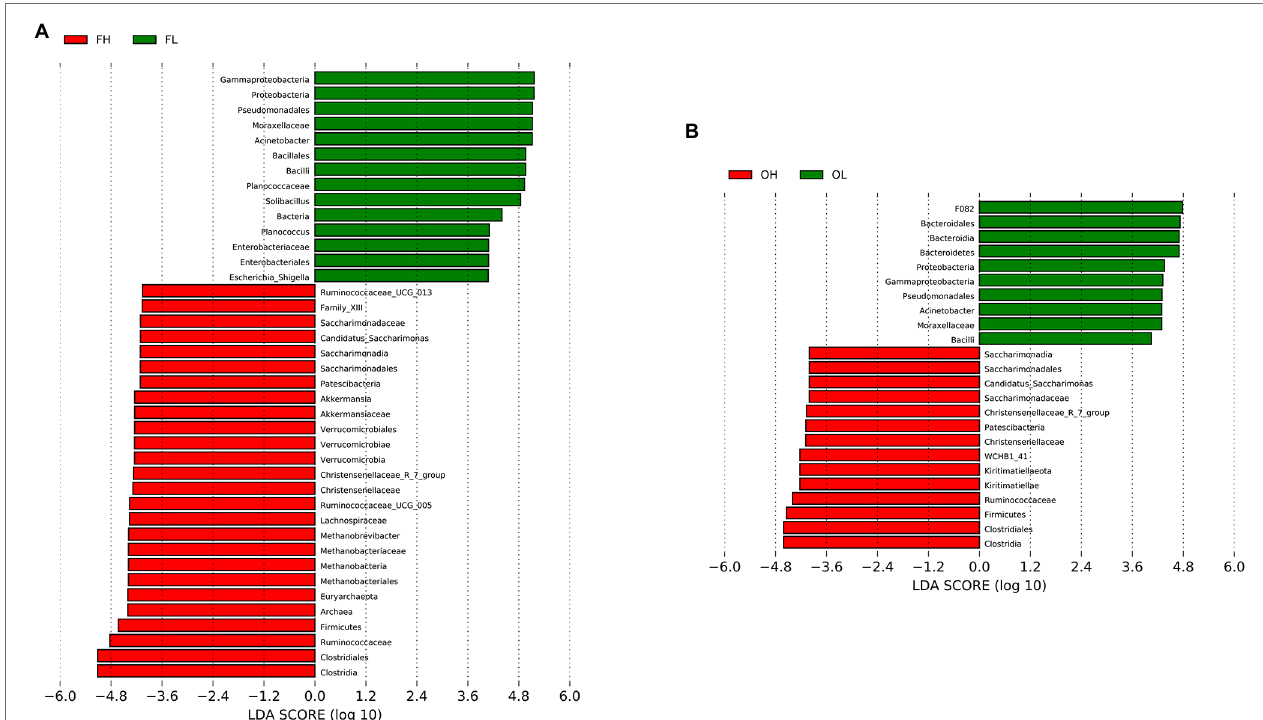
FIGURE 7 | LEfSe (LDA Effect Size) analysis in ungulates between different altitudes. (A) Group FH (high-altitude Artiodactyla, including groups HB, HT, and HY) vs. group FL (low-altitude Artiodactyla, including groups LB and LY); (B) Group OH (high-altitude Perissodactyla, group HA) vs. group OL (low-altitude Perissodactyla, group